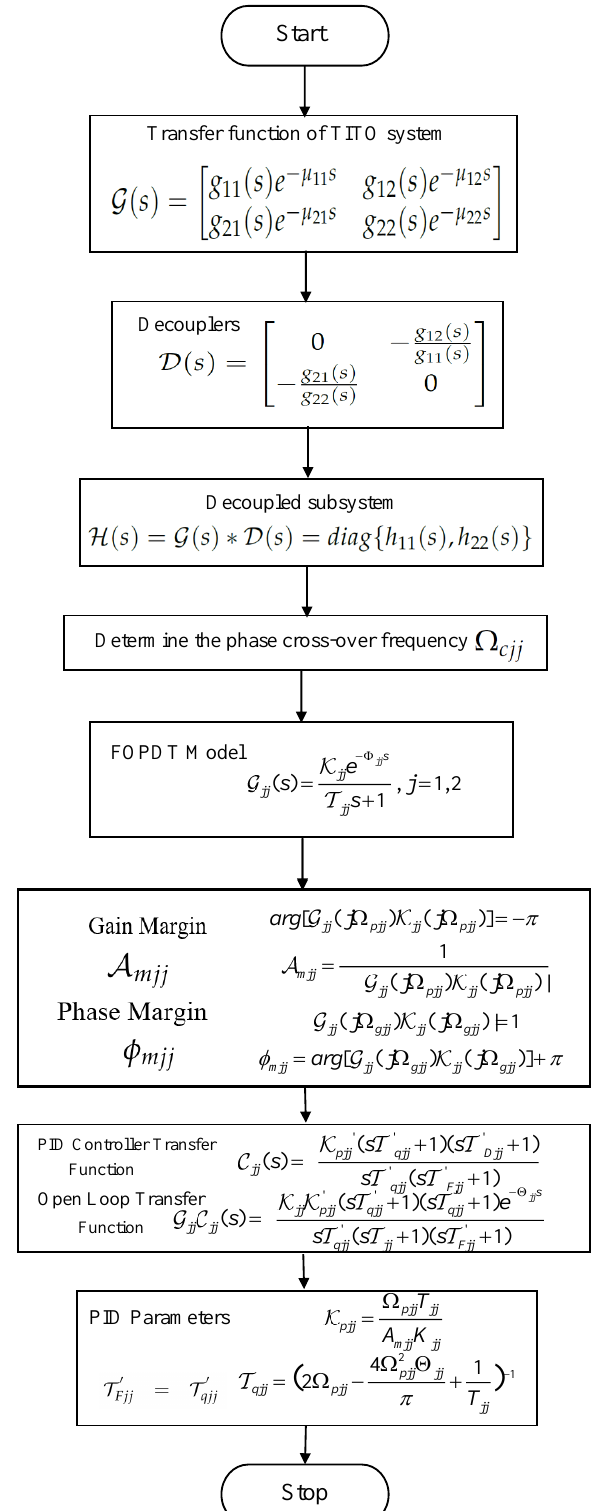
Figure 3. Flow chart for PID controller